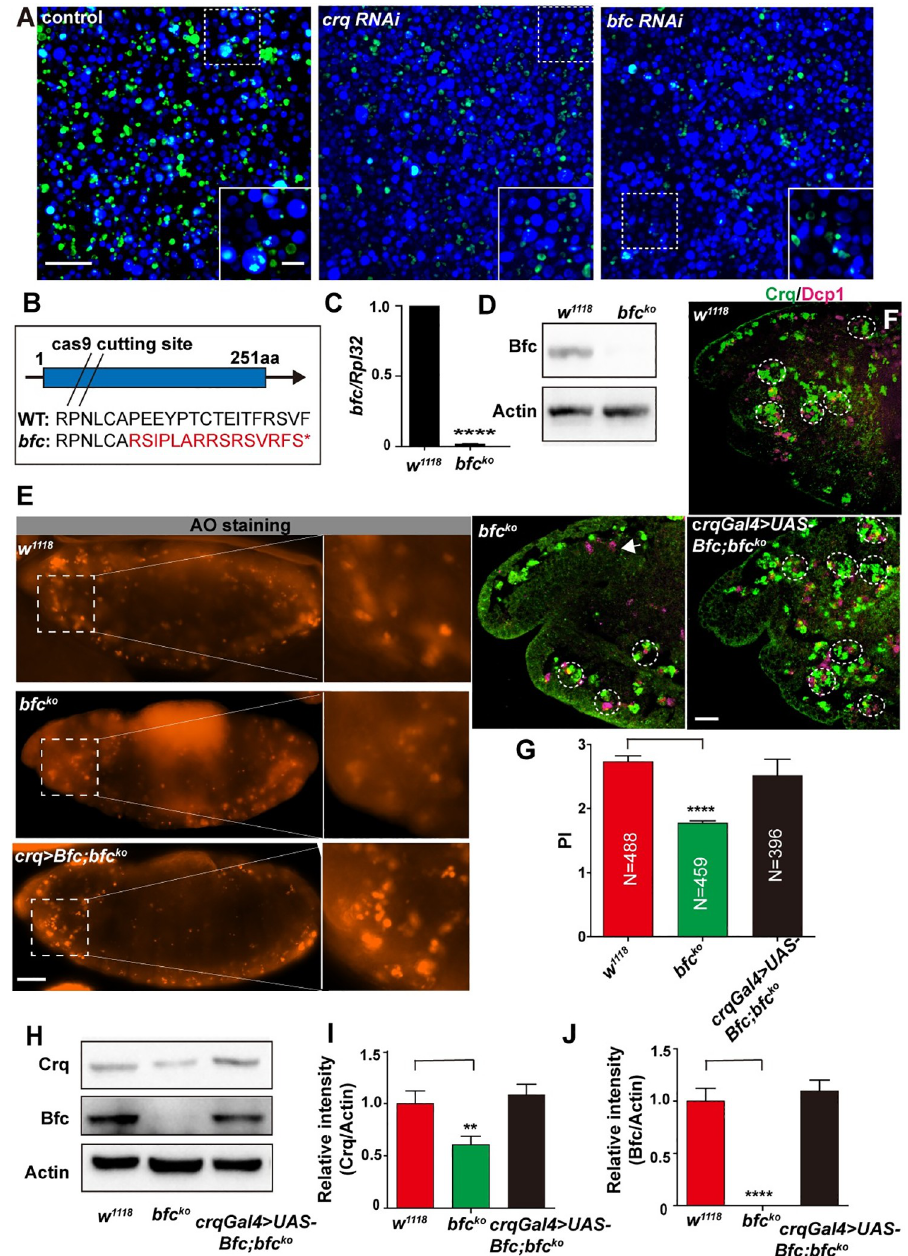
Fig 3. bfc in macrophages and S2 cells is required for efficient efferocytosis. A. Confocal images showing AC efferocytosis by control-, crq RNAi-, and bfc RNAi-treated S2 cells (the efferocytosis efficiency is quantified in Fig 2C ). Live cells are shown in blue, while cells that engulfed FITC-labeled ACs are shown in green. Scale Bars = 50 μ m. B. Schematic diagram of the bfc ko mutant created by CRISPR/Cas9. The exon is denoted as a blue box, and the transcriptional direction is highlighted with an arrow. The double slash represents the Cas9 cutting site. The red marked amino acids represent the mutated sequence. “ � ” represents the introduced termination codon. C. The bfc mRNA levels were quantified by qPCR in w 1118 and bfc ko mutant samples. D. The Bfc protein levels were also quantified via western blotting in w 1118 and bfc ko mutant samples. Actin was used as the loading control. E. AO-stained wild-type, bfc ko mutant, and bfc ko mutant re-expressing UAS-bfc (under the control of a crq-Gal4 driver) stage 13 embryos. The insets represent the higher-magnification views of the demarked AO-stained corpses. Scale bar = 20 μ m. F. Confocal stacks of the head region of stage 13 embryos on the lateral view. Macrophages and apoptotic bodies were stained with anti-Crq (green) and anti-Dcp1 (magenta) antibodies, respectively in wild-type, bfc ko mutant, and bfc ko ; crqGal4 > UAS-bfc embryos, which were imaged using the enhanced similarly to show macrophages. Scale bar = 20 μ